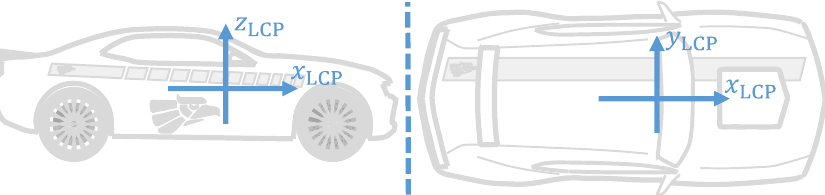
Figure 1. Graphical depiction of the Local Car